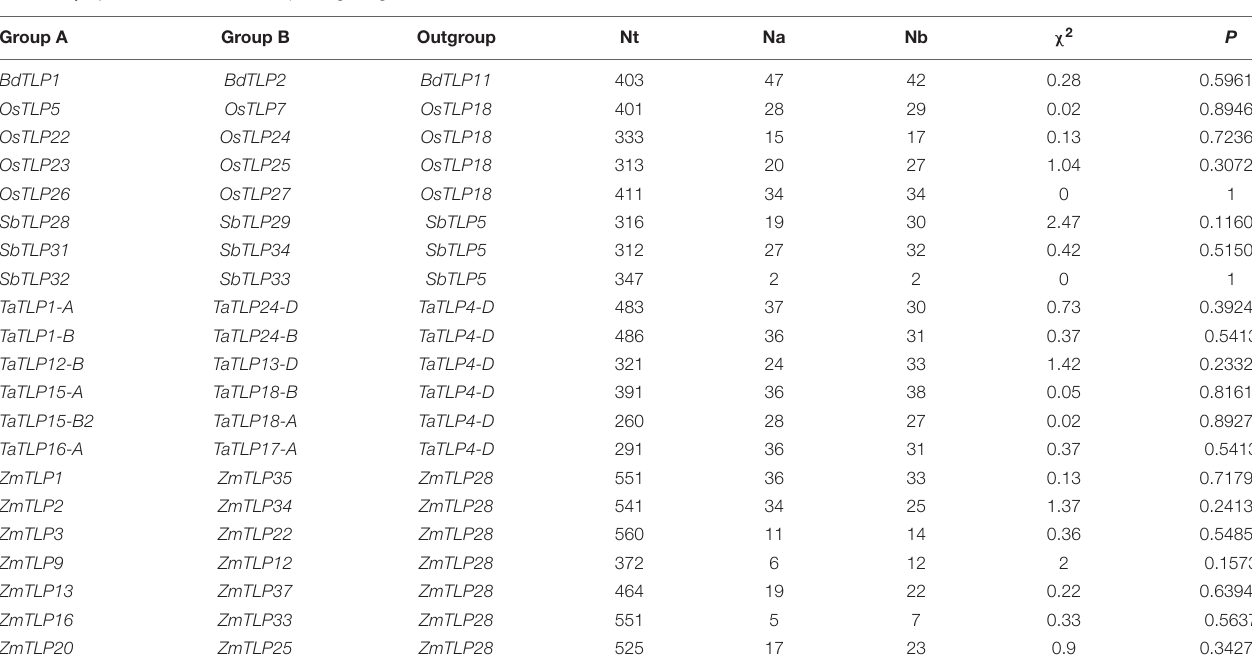
TABLE 2 | Tajima’s relative rate test of paralogous